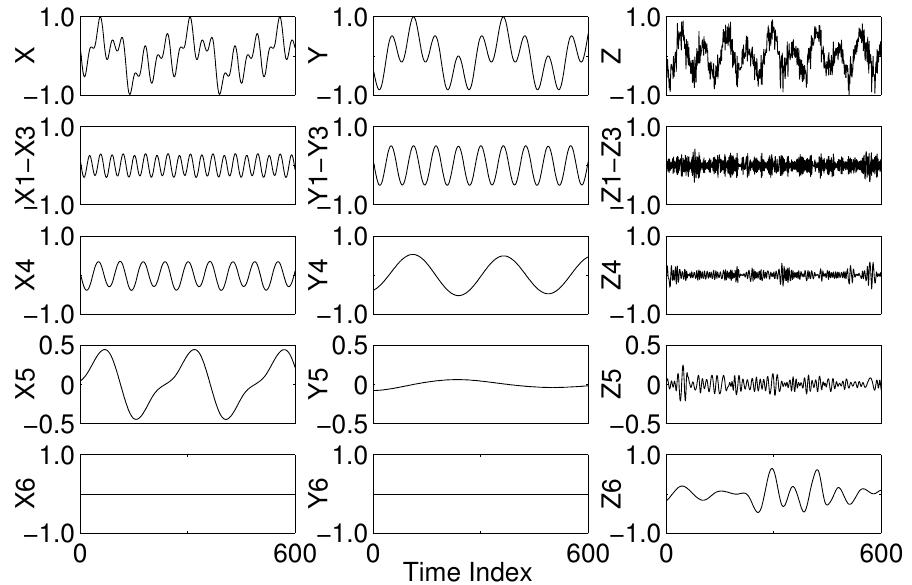
Figure 1. EMD decomposition of a synthetic trivariate dataset showing mode mixing and mode misalignment due to the empirical nature of